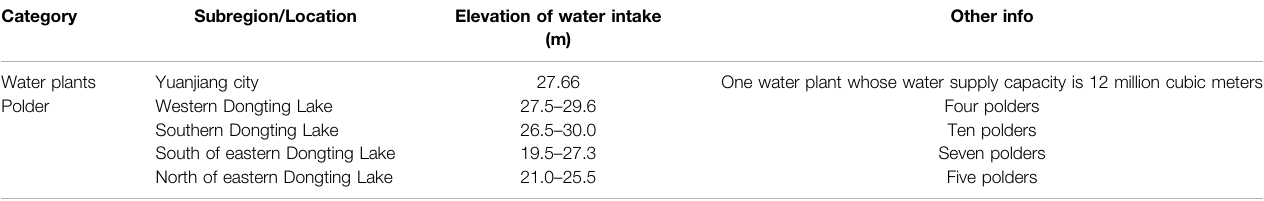
TABLE 2 | Water intake